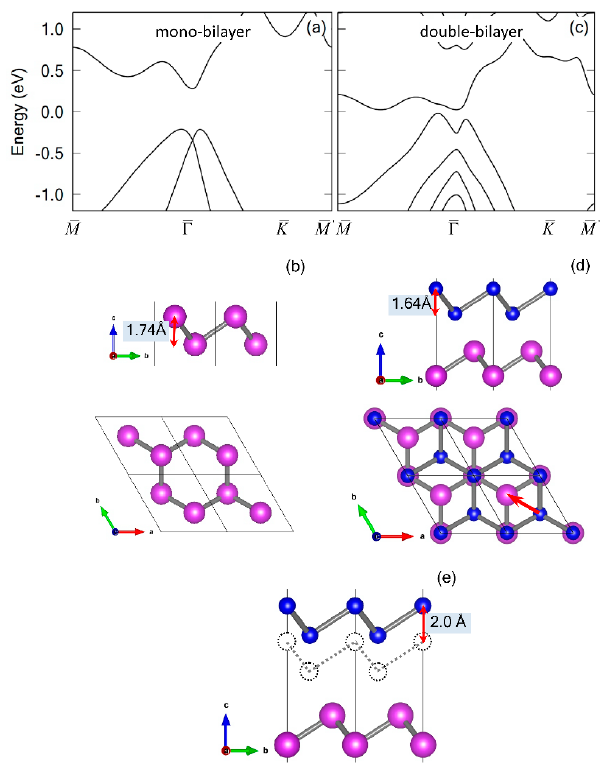
Figure 1. Band structure ( a ) and ball-and-stick model ( b ) of mono-bilayer bismuthene. The intra-bilayer buckling is indicated. ( c ) and ( d ) are the band structure and atomic model of double-bilayer bismuthene, respectively. The top bilayer Bi atoms are represented by small blue balls and the bottom bilayer by big magenta balls. The intra-bilayer buckling is indicated as well. The red arrow in ( d ) indicates how the two bilayers of bismuthene are stacked and shifted to form a double-bilayer bismuthene. ( e ) is the atomic model of double-bilayer bismuthene with 2.0 Å extra inter-bilayer spacing. The position of the top bilayer in equilibrium geometry is indicated with dotted circles.